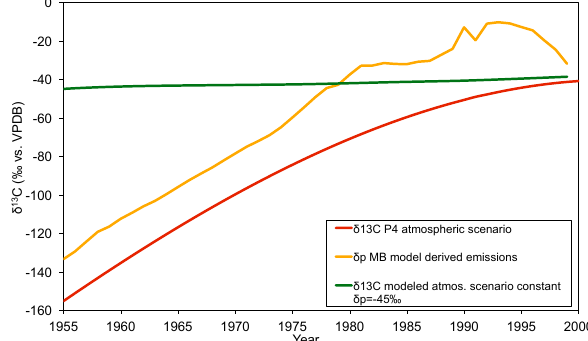
Fig. 9. Temporal evolution of reconstructed atmospheric δ 13 C val- ues (‰, red, best fit 4th degree polynomial from firn air modeling) which are used as mass balance model input to calculate δ 13 C of the CFC-12 emissions ( δ p , orange); mass balance calculated atmo- spheric scenario with constant δ p = − 45‰ and initial (1955) δ of − 45‰